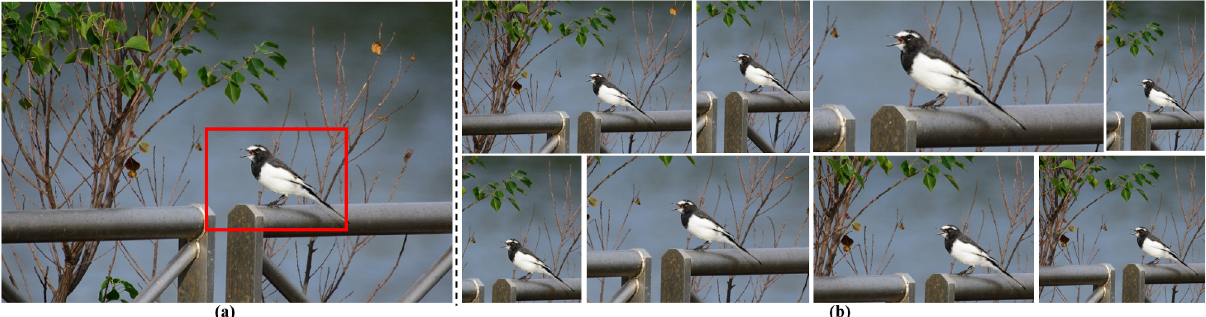
Fig. 3 Example ground truth windows in SACD. (a) An original image; the red box represents the assigned subject. (b) Eight ground truth composition windows for this image, containing the assigned